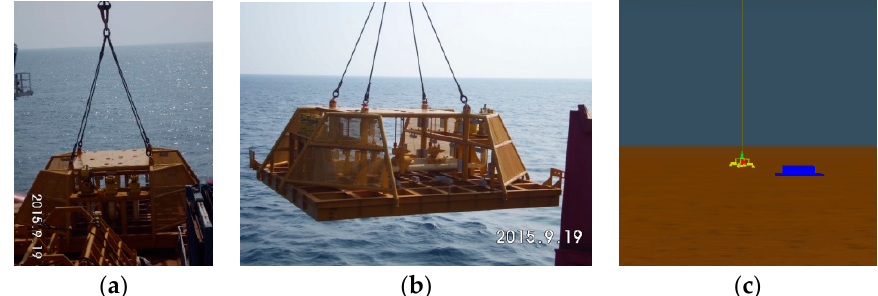
Figure 1. The subsea tree passing through the splash zone (from left to right): ( a ) Pass through the splash zone, ( b ) Continue decentralization, ( c ) Lower to the designated position.